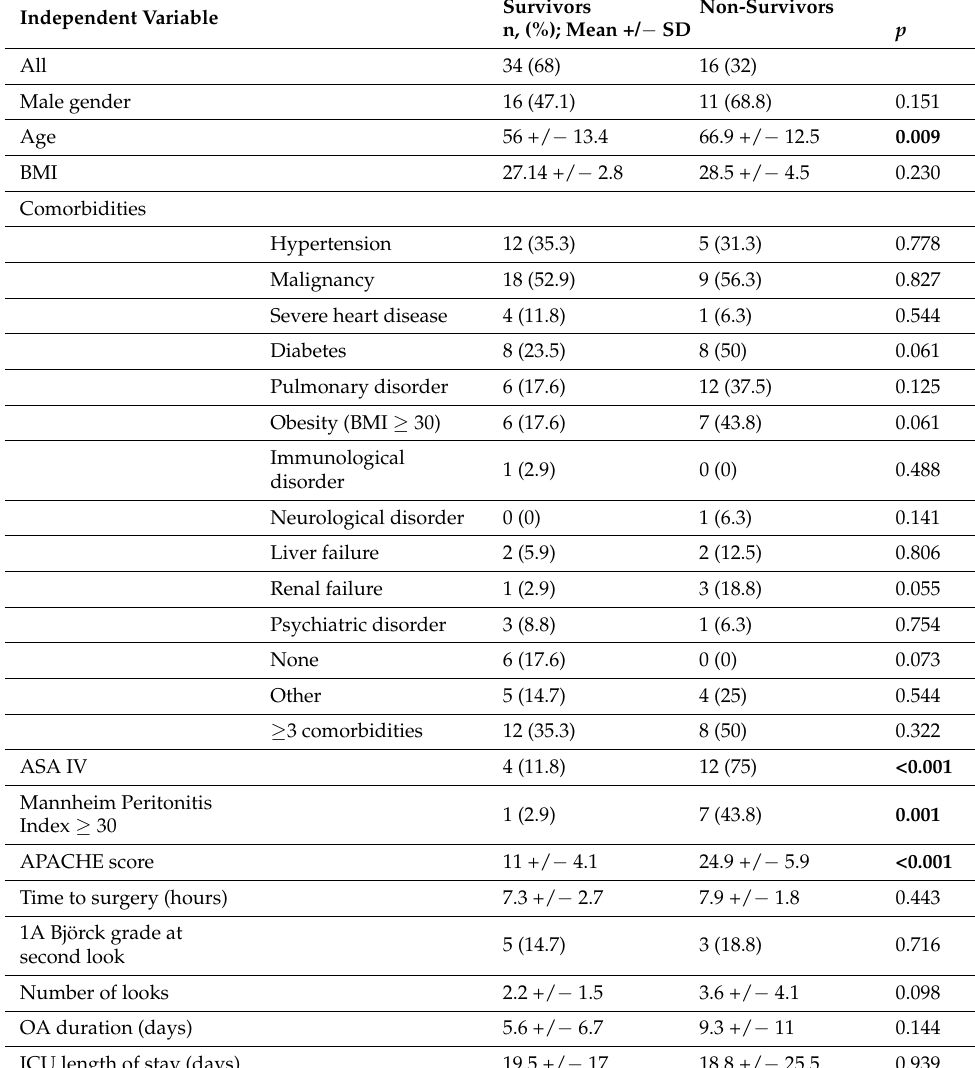
Table 4. Univariable